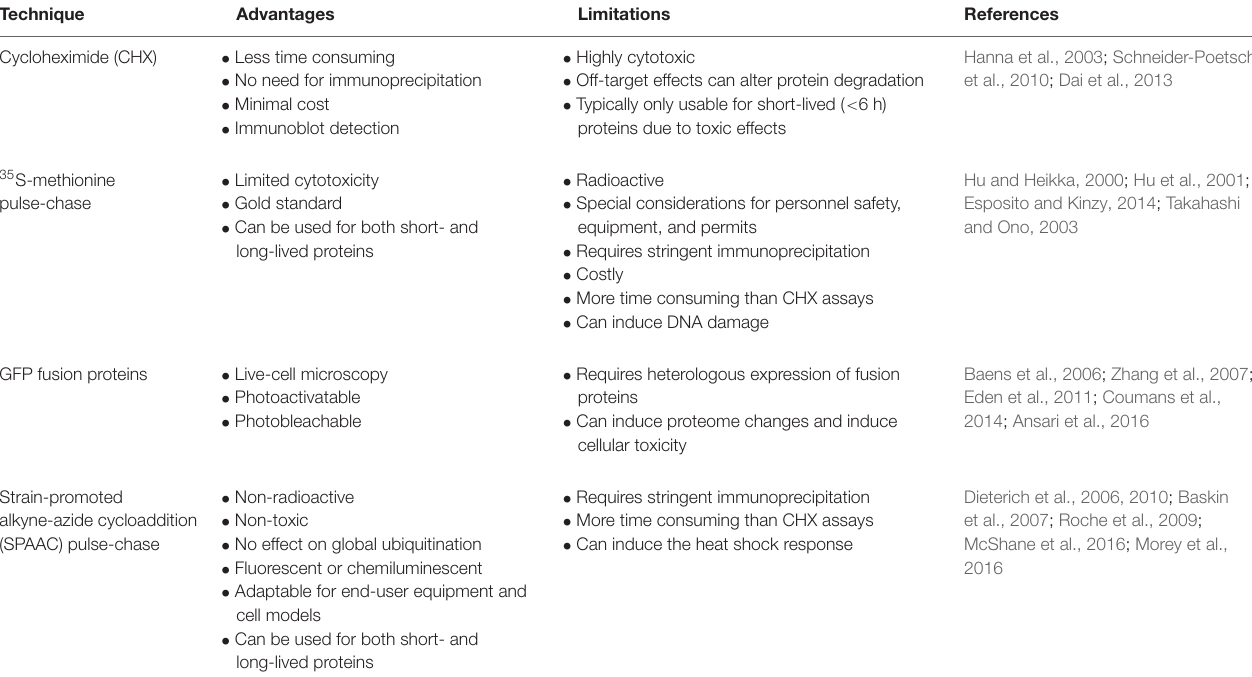
TABLE 1 | Comparison of SPAAC pulse-chase to existing protein half-life methods. Technique